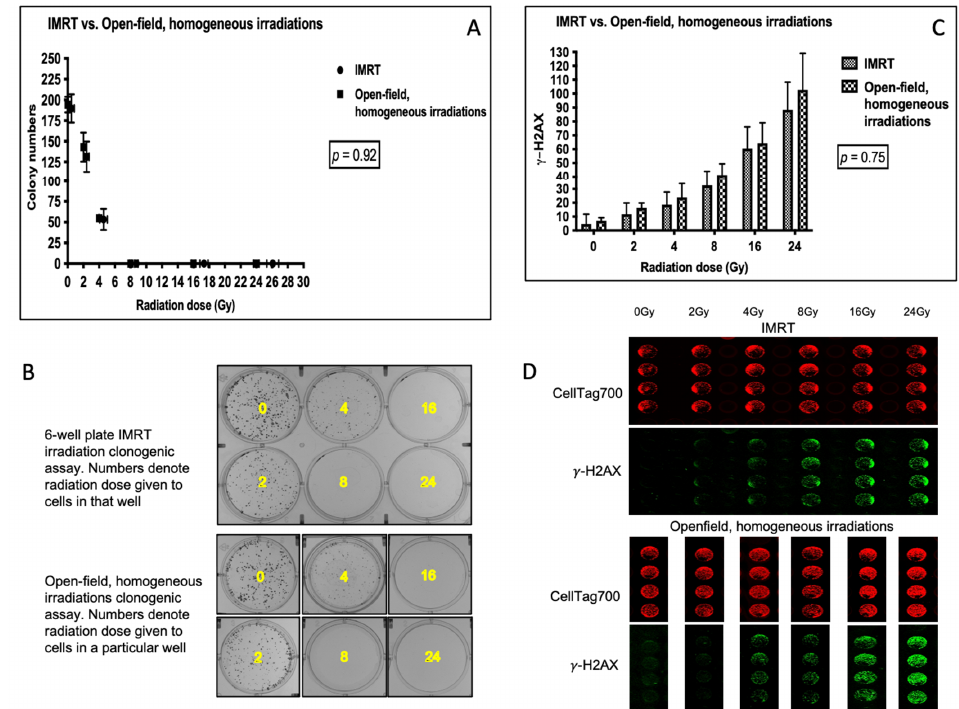
Figure 5. ( A , B ) Comparison of A375 colony numbers between 6-well tissue culture plate IMRT and